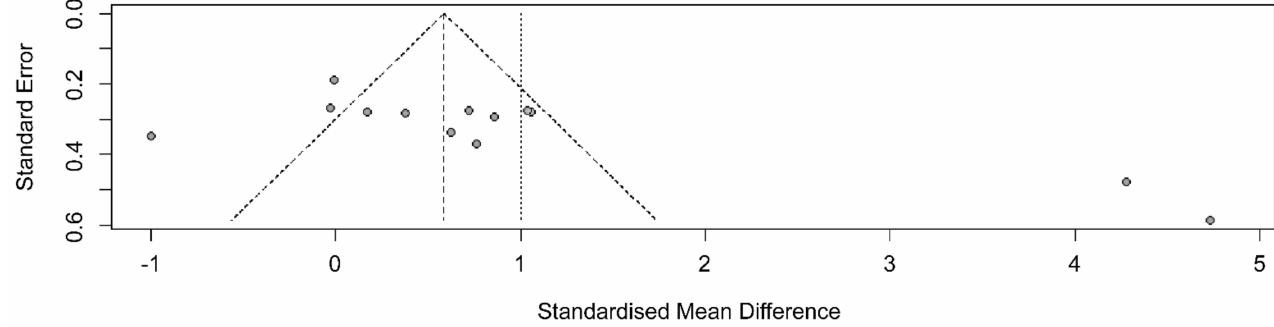
Figure 4. Funnel plot showing the effects of non-pharmacological interventions. After removing five outliers, I 2 dropped from 92% (Q = 155.4, df = 12, p < 0.001) to I 2 = 17% (Q = 8.40, df = 7, p = 0.298). The average effect size (Hedge’s g) in the random effects model decreased from 1.00 (95% CI 0.16, 1.85) to 0.70 (95% CI 0.47, 0.93), but statistical significance was maintained (Figure